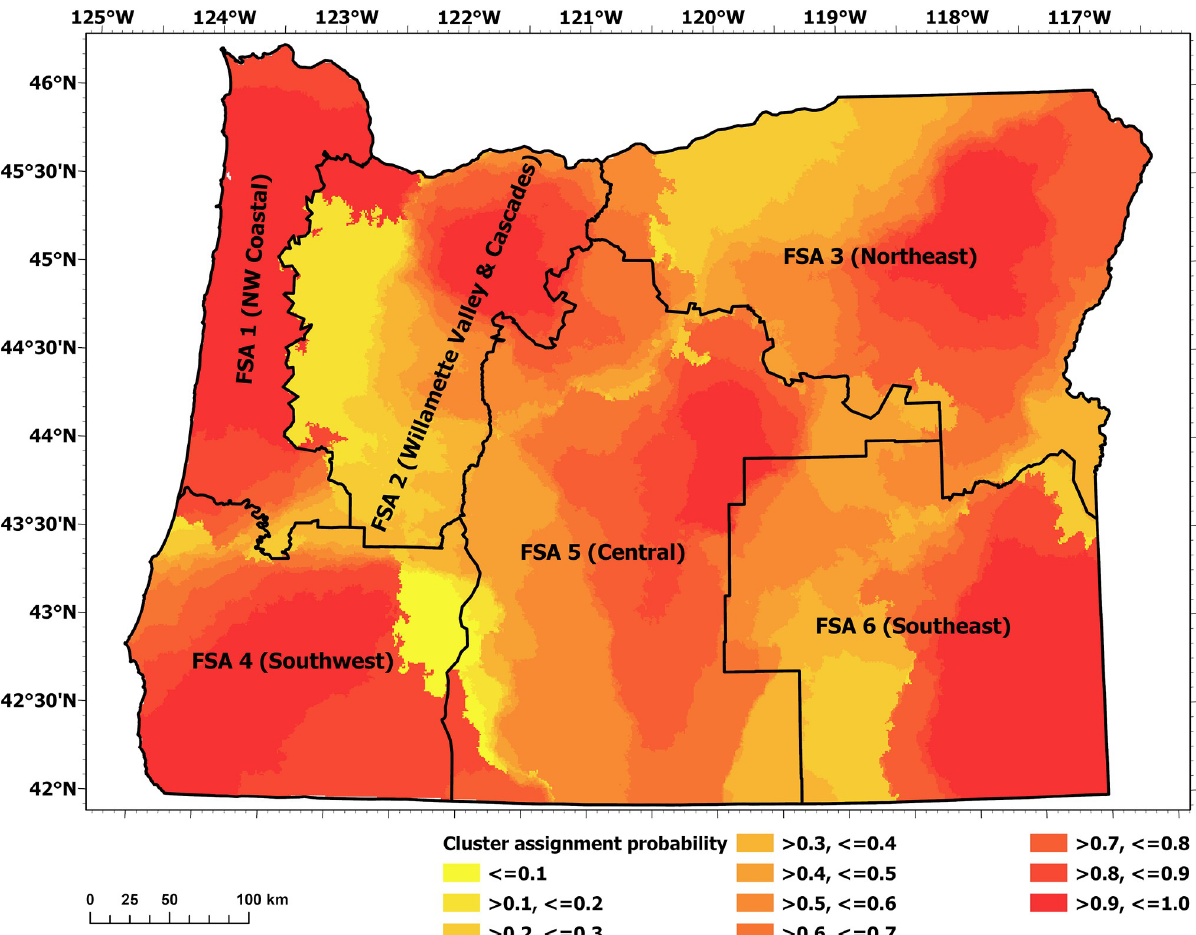
Fig 2. Cluster assignment probabilities of the SCMC procedure including the overlaid final FSA